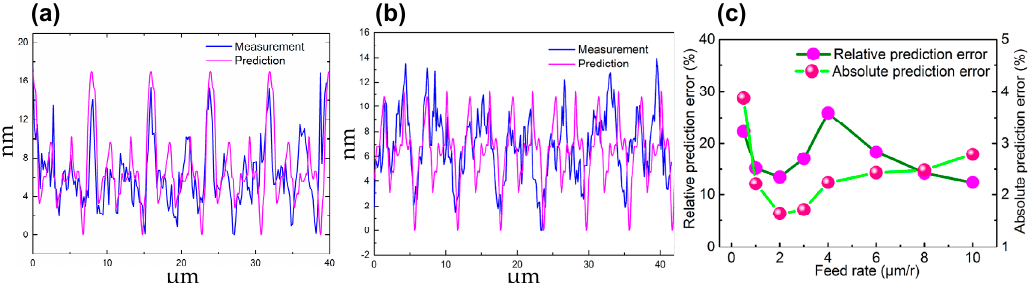
Figure 11. The prediction and measurement results for 2D surface topography on different cutting conditions and the corresponding prediction error: ( a ) topography achieved at f = 8 μ m/r; ( b ) topography achieved at f = 6 μ m/r; ( c ) the prediction error vs. feed rate. Reproduced with permission from [28].